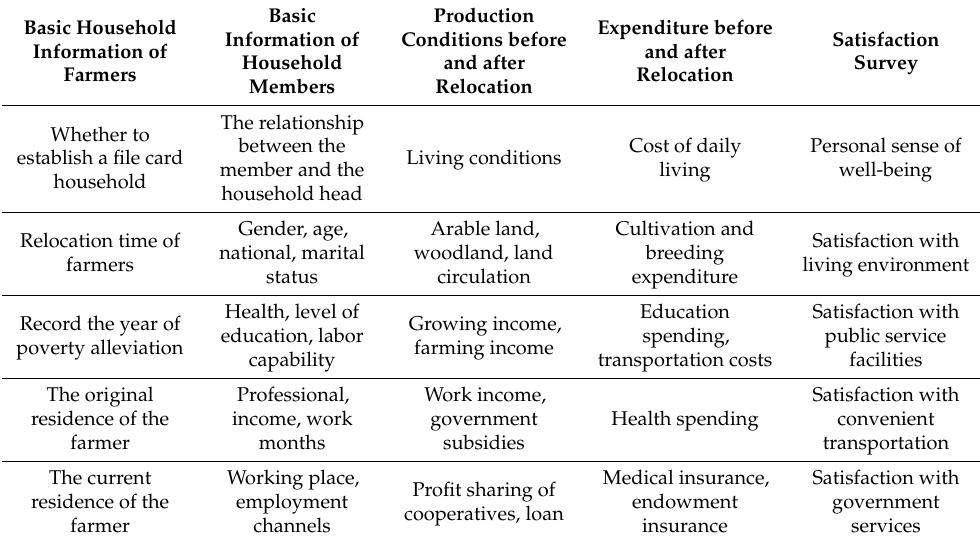
Table 1. Questionnaire information.